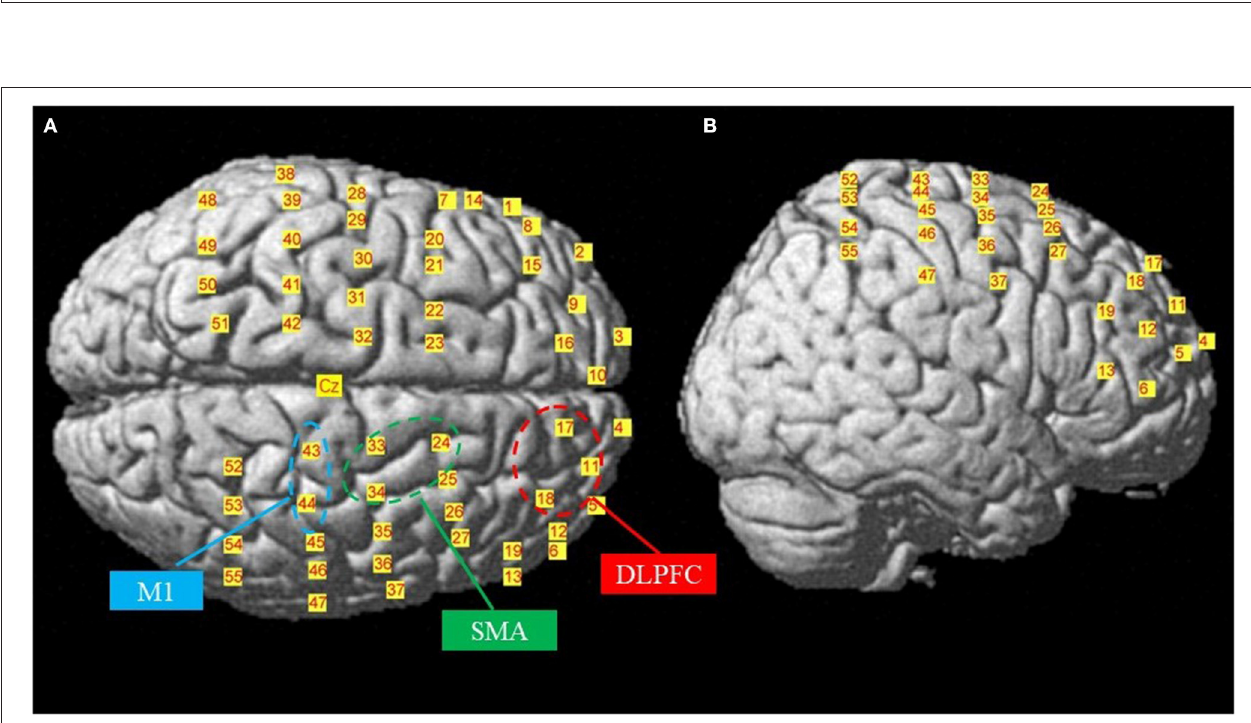
Frontiers in Neurology | www.frontiersin.org